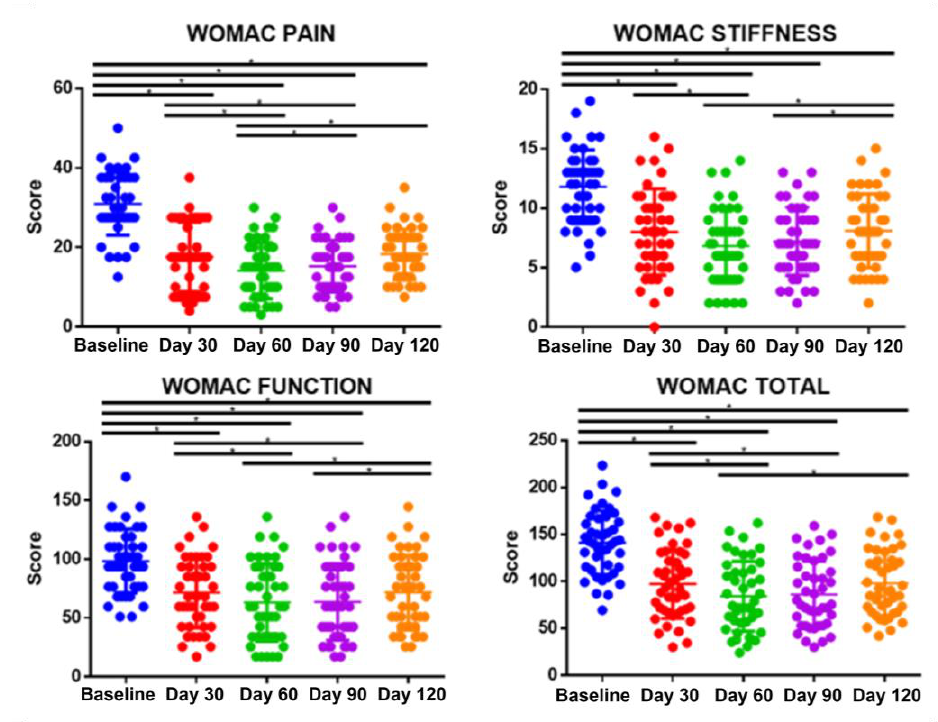
Figure 7. The WOMAC score of each observation point, treatment period: day 30 and day 60; post treatment period: day 90 and day 120; One-way ANOVA, Tukey’s test, n = 43, * p < 0.05.